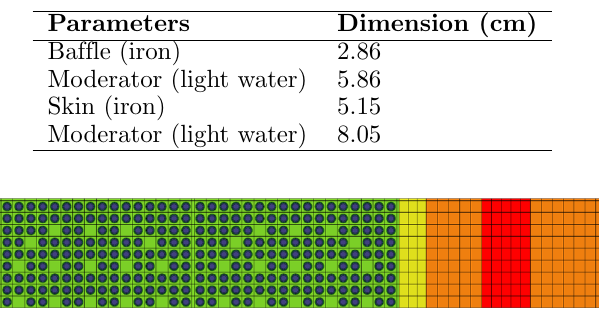
Fig. 2. Reflector geometry. Materials are identified as follows: moderator (fuel assembly) in green, UOx fuel pellet in pur- ple, iron (baffle) in yellow, iron (skin) in red and moderator (reflector) in orange.